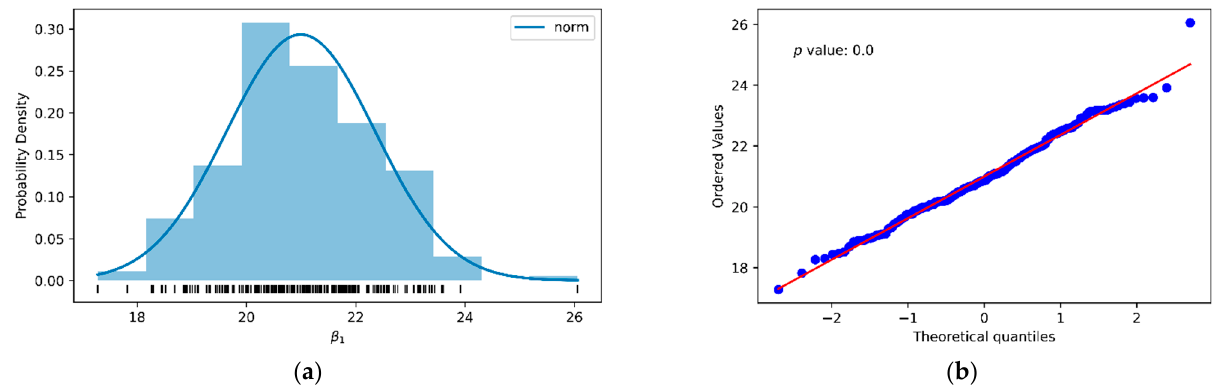
Figure 5. Histogram with distribution curve ( a ) and normal probability plot ( b ) of slope ( β 1 ) between σ c and I s of the travertine, from the least squares fit of 10 pairs of data points selected from 200 random samples. Table 10. Results of the normal distribution of the linear fit for the σ c and I s pairs of the travertine.